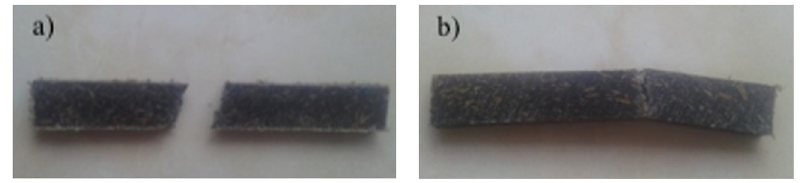
Figure 3: Fracture of specimens during impact test: ( a ) r - HDPE/30% bamboo fi ber and ( b ) r - HDPE/10% bamboo fi ber.